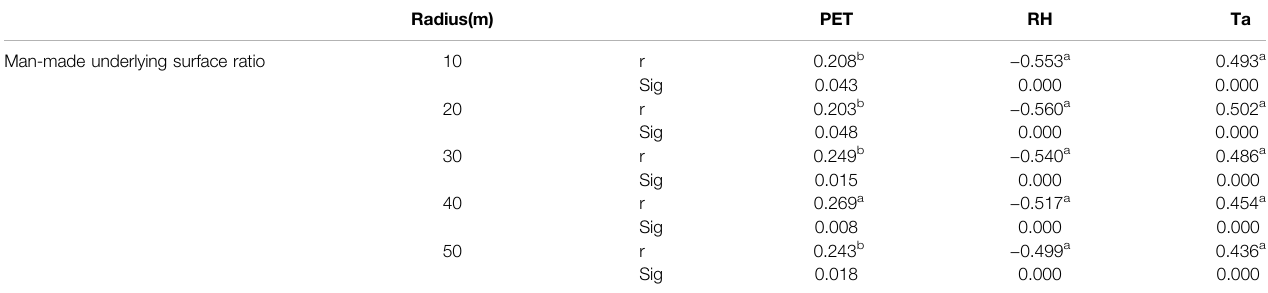
TABLE 8 | Correlation coef fi cients between man-made underlying surface ratio and simulated data within different buffer radiuses. Radius(m) PET Ta Man-made underlying surface